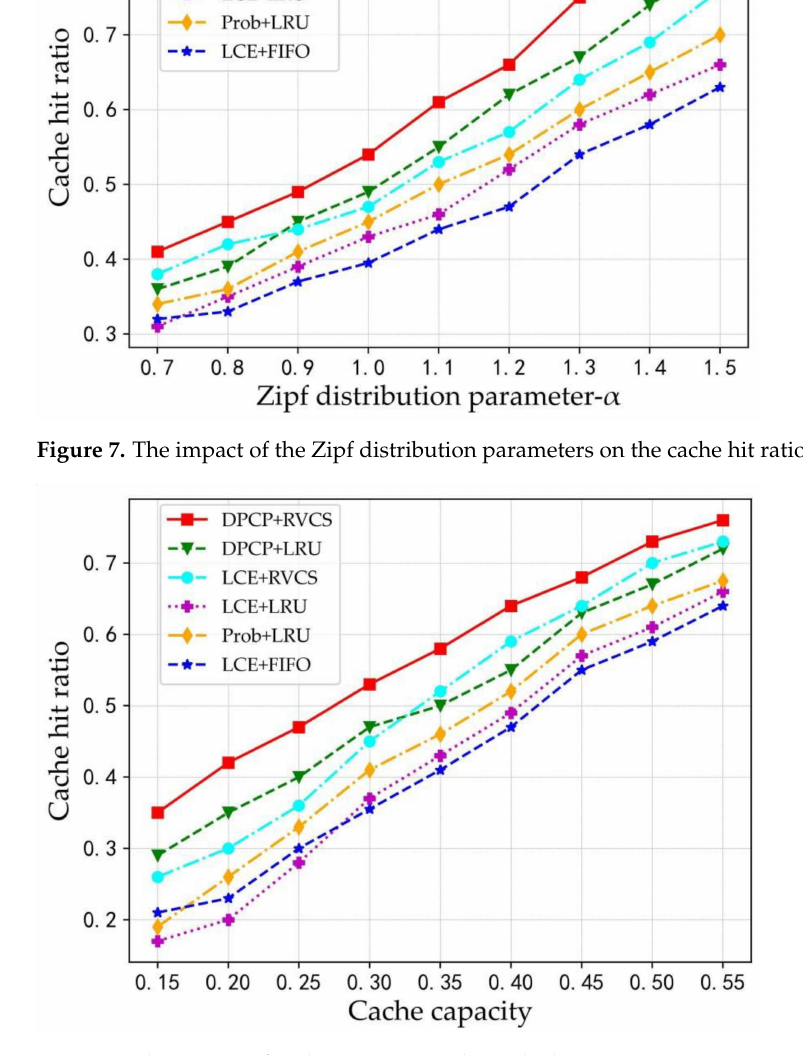
Figure 8. The impact of cache capacity on the cache hit